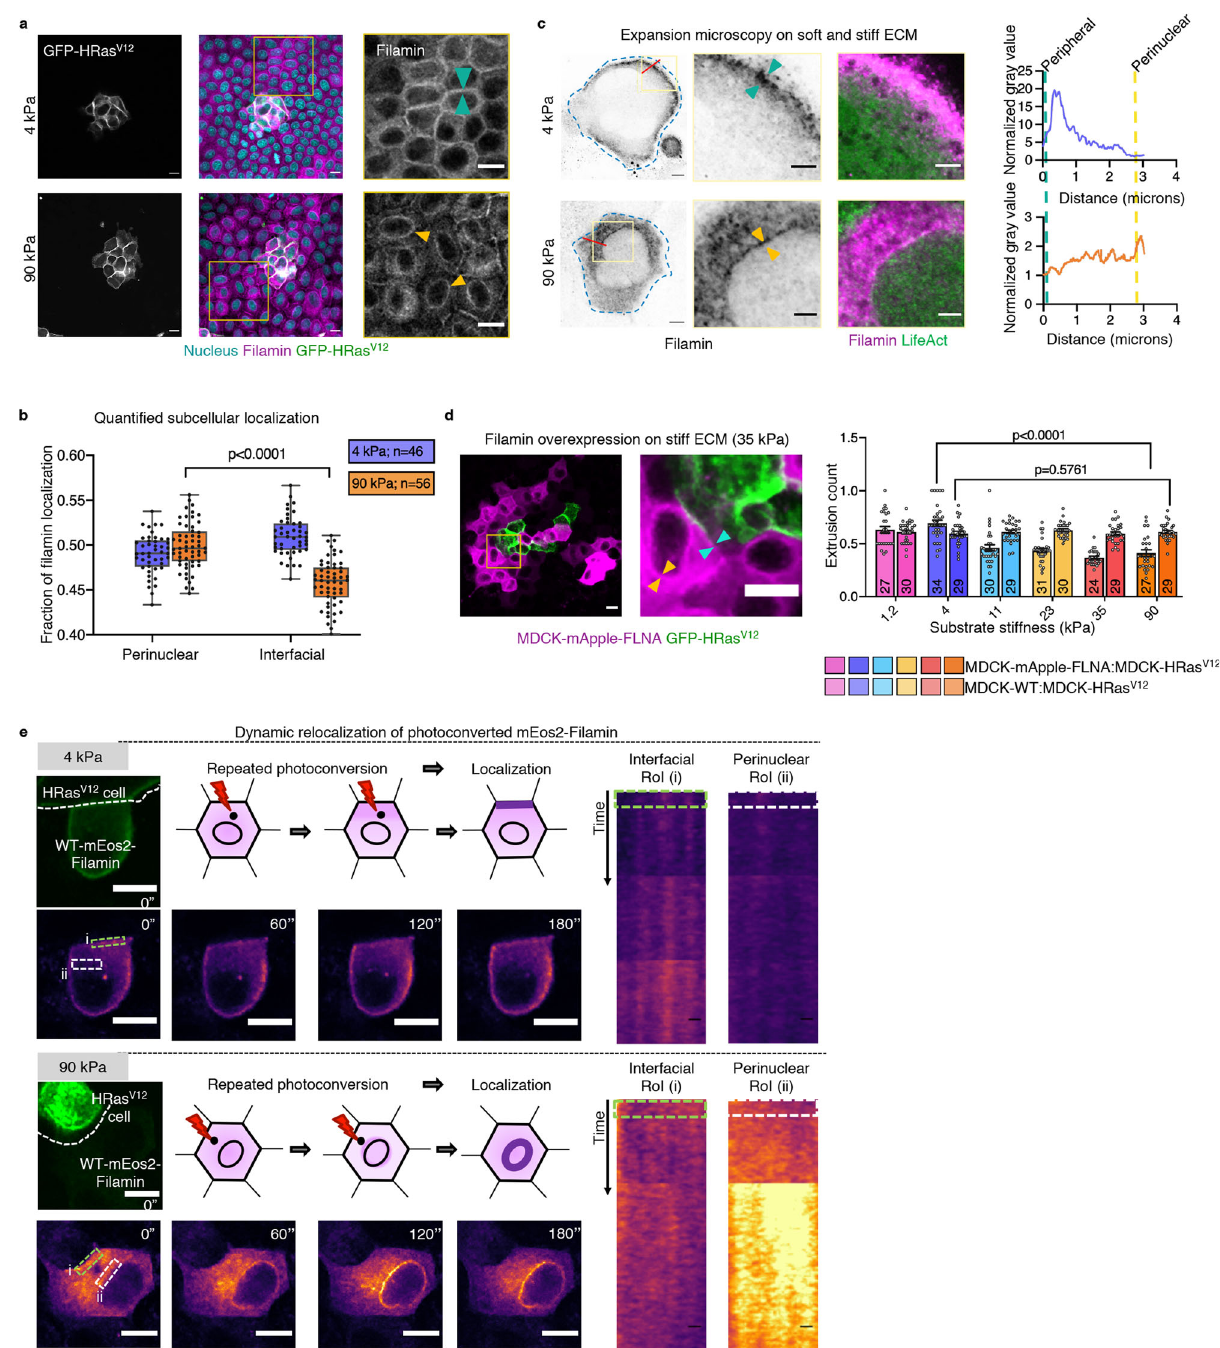
region (Fig. 2e, bottom panels , Supplementary Video 4). More- over, a separate set of photobleaching experiments in mApple- fi lamin expressing cells showed that on stiff ECM, fi lamin had two dynamically different populations — interfacial and peri- nuclear (Supplementary Fig. 3g, h), in terms of the speed of recovery after photobleaching. On stiff ECM, the perinuclear population was more dynamic and recovered faster than the interfacial population (Supplementary Fig. 3g, h). A comparison of the fi lamin population dynamics between soft and stiff ECM interestingly revealed that the perinuclear pool on stiff ECM matched very closely to that of the interfacial population on soft ECM (Supplementary Fig. 3h). This indicated that from a dynamics perspective, the perinuclear population of fi lamin